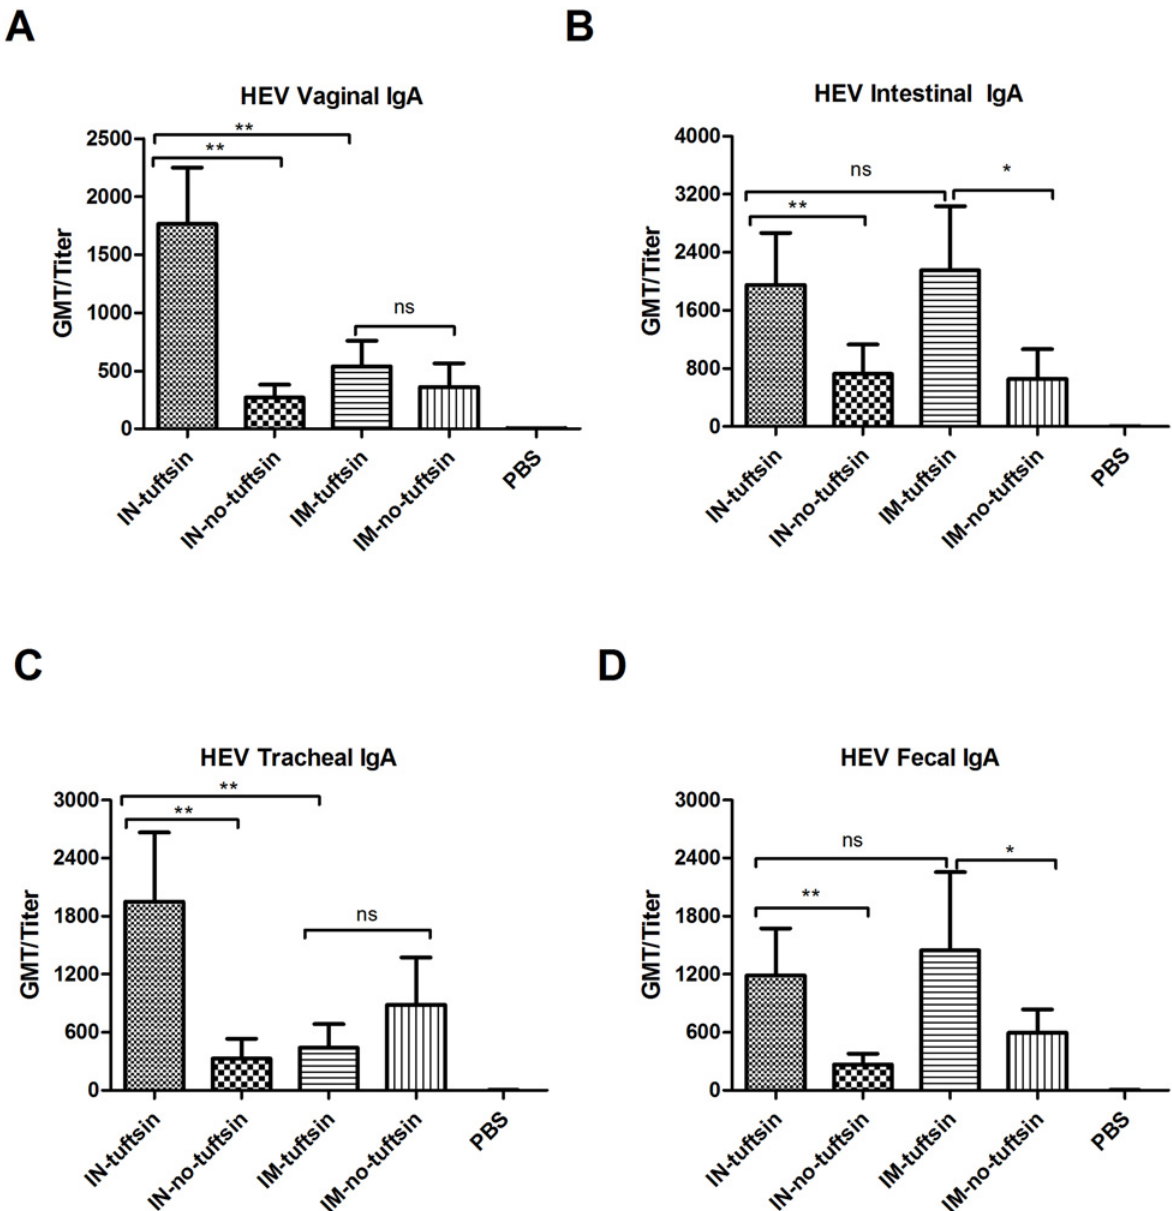
Fig 4. Profiles of HEV-specific IgA production in mucosal immune response to vaccination. HEV IgA was detected by indirect ELISA in (A) vaginal secretions, (B) intestine, (C) respiratory tract and (D) stool homogenates of the mouse groups immunized as indicated in Fig 2. Each serum effective dose (presented as the GMT) is the reciprocal value of the maximum positive dilution. Error bars represent the SEM. * , P < 0.05, ** , P < 0.01, *** , P < 0.001; ns, no significant difference.